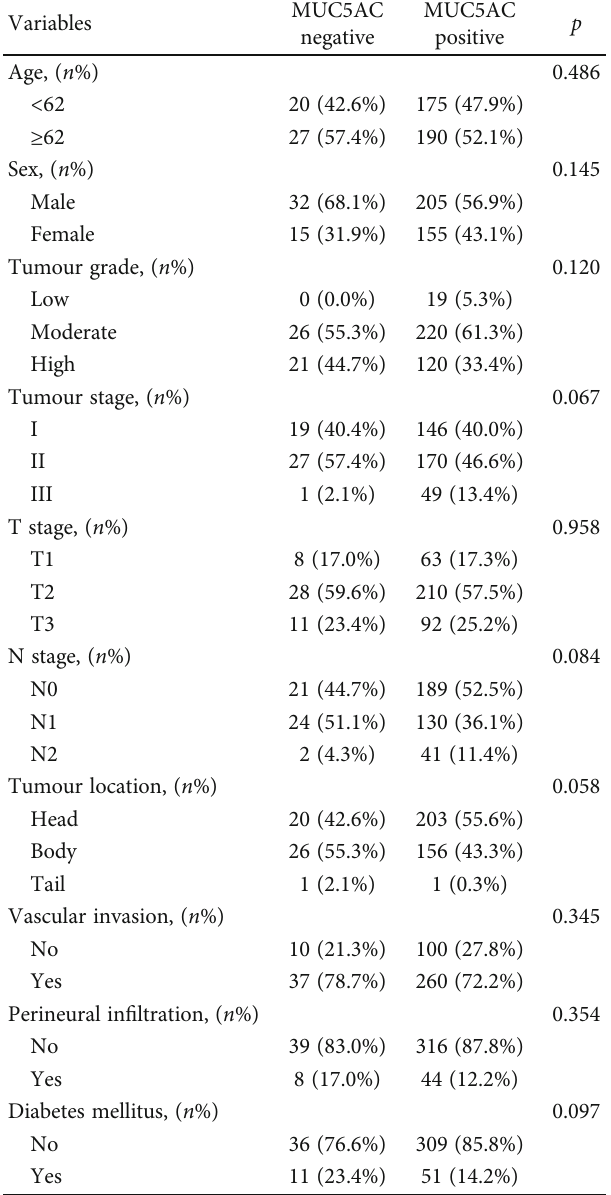
Table 3: Clinicopathological characteristics of FUSCC PDAC patients strati fi ed by MUC5AC